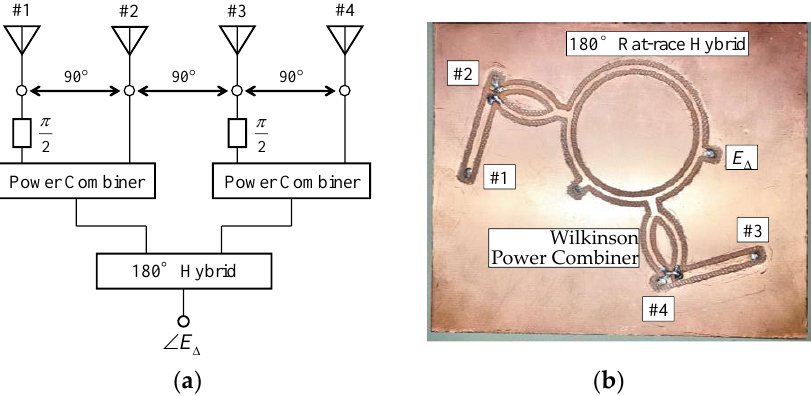
Figure 12. Small-sized AOA network: ( a ) schematic diagram and ( b ) fabricated AOA network.